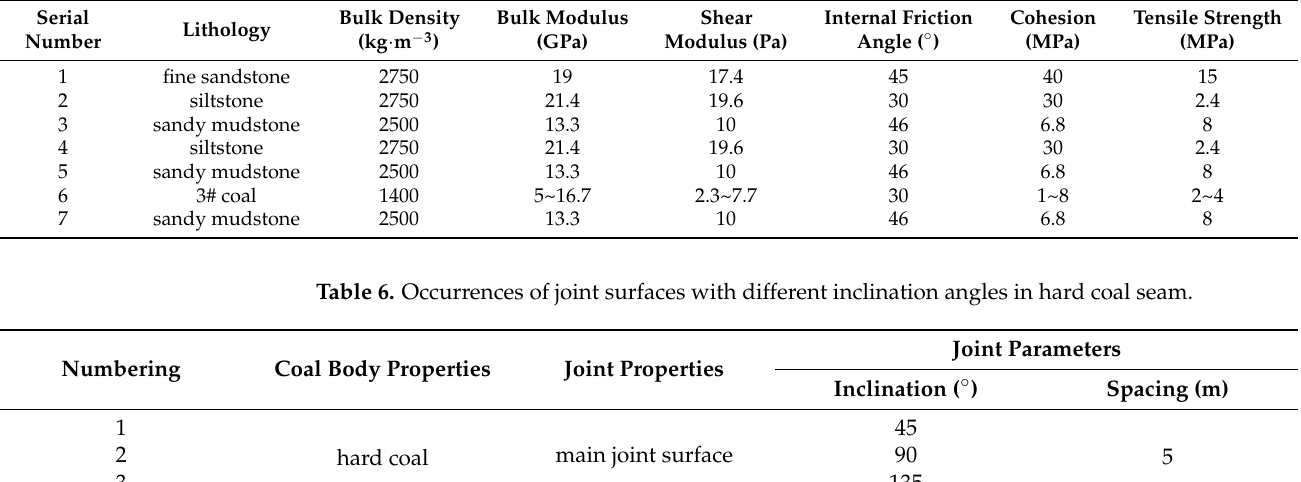
Table 5. Mechanical parameters of coal and rock.